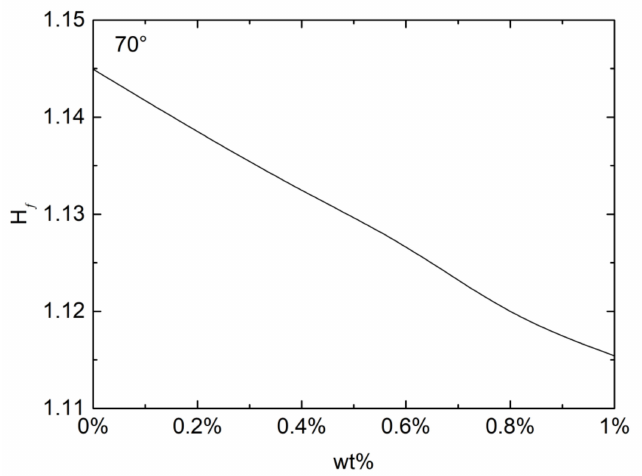
Figure 3. Equilibrium droplet height with respect to PEO concentration at a voltage of 10 kV and a contact angle of 70 ◦